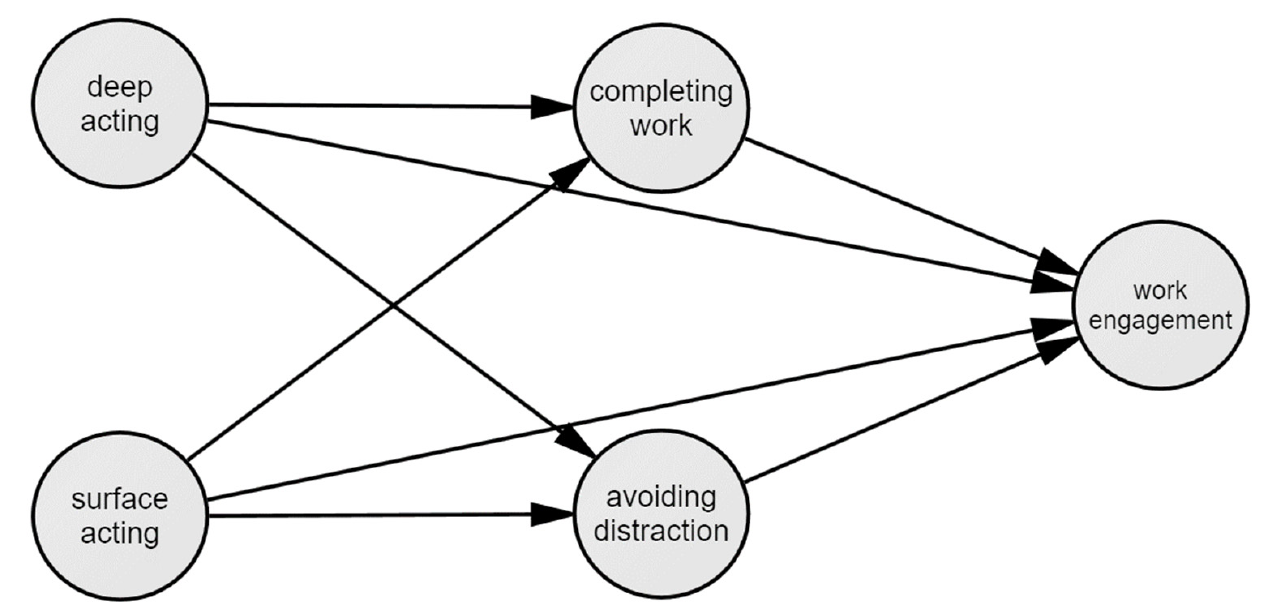
Figure 1. Measurement model.